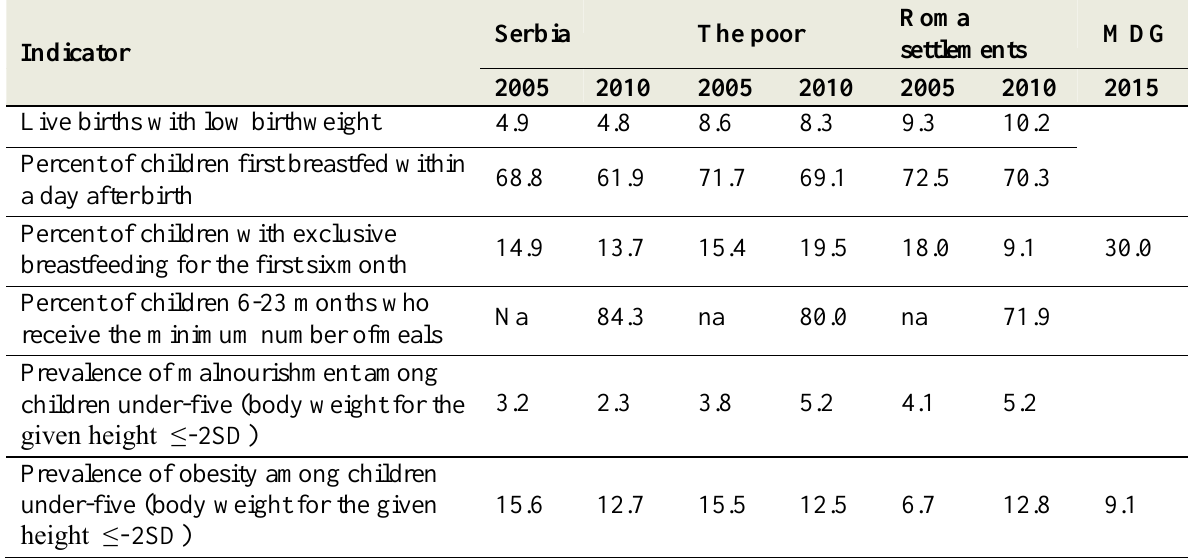
Table 1. Diet and nutritional status of children under five years of age in 2005 and 2010 in Serbia Serbia The poor